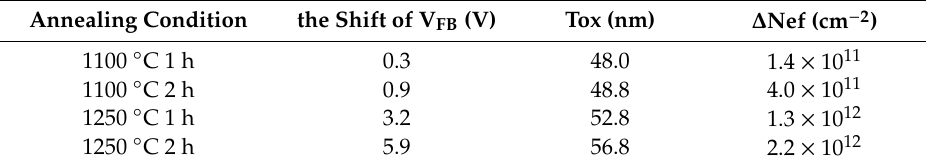
Figure 13. The schematic diagram of main traps a ffecting V FB during irradiation nearby the SiO 2 / 4H-SiC interface.